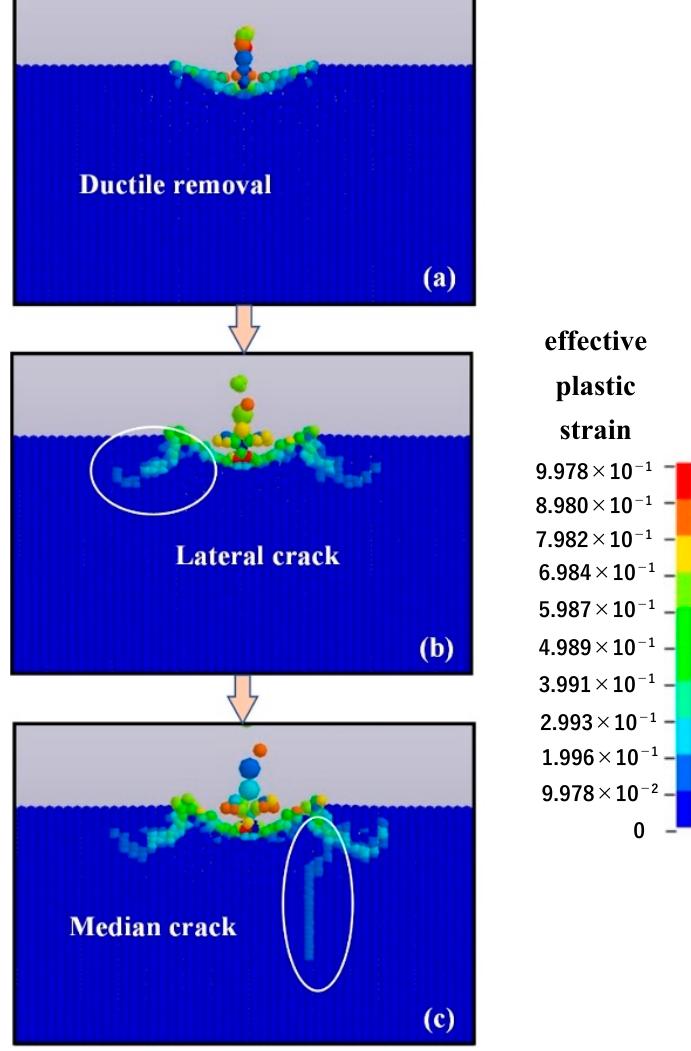
Figure 8. Erosionremovalprocessofopticalglass: ( a )ductileremoval, ( b )lateralcrack, and( c )radial Figure 8. Erosion removal process of optical glass: ( a ) ductile removal, ( b ) lateral crack, and ( c ) radial crack.